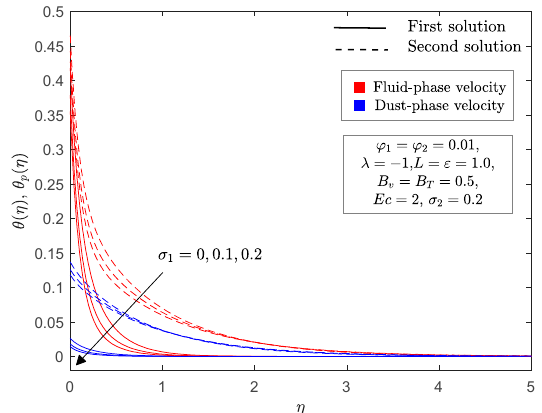
Figure 11. θ ( η ) , θ p ( η ) for selected values of σ 1 . Figure 11. ( ) ( ) θη θ η for selected values of σ , Figure 11. p 1 The distribution of velocity f (cid:48) ( η ) , f p (cid:48) ( η ) and temperature θ ( η ) , θ p ( η ) profiles for selected values of fluid particle interaction parameters for velocity B v and temperature B T are plotted in Figures 13 and 14. For increasing velocity fluid particle interaction parameter B v , the momentum boundary layer thickness decreased for the fluid phase, while the opposite occurred for the dust phase in the first solution. Nevertheless, the thickness of the momentum boundary layer increased in the second solution for both phases. Additionally, the temperature profile θ ( η ) in Figure 14 indicates that the